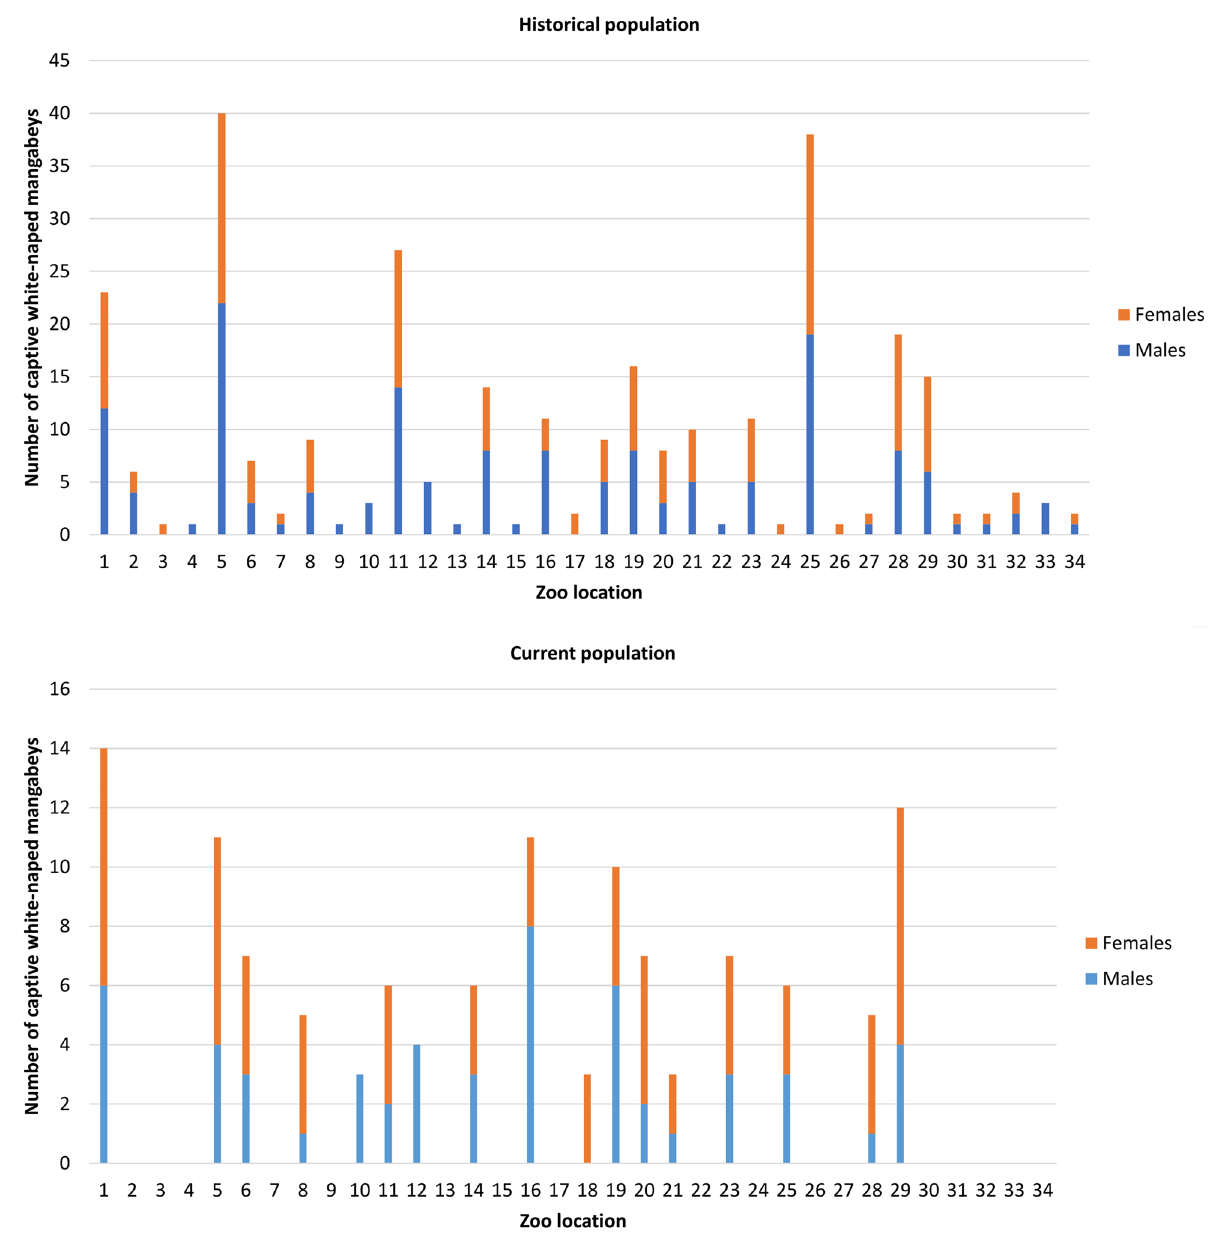
Figure 1. Historical and current distribution of individuals across